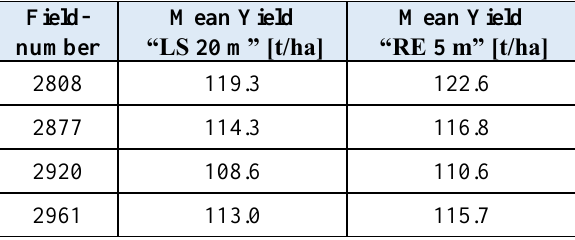
Table 4: Results of the yield estimation for the “Landsat like